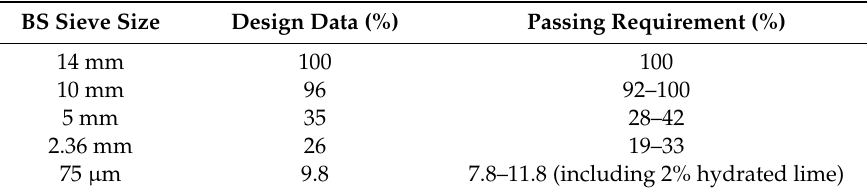
Table 2. SMA 10 gradation used in this